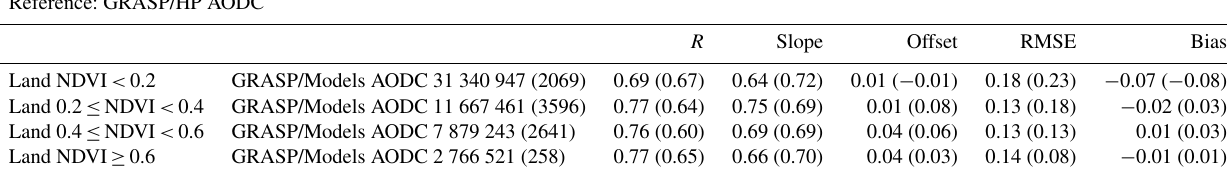
Table 23. The same as Table 22, but for